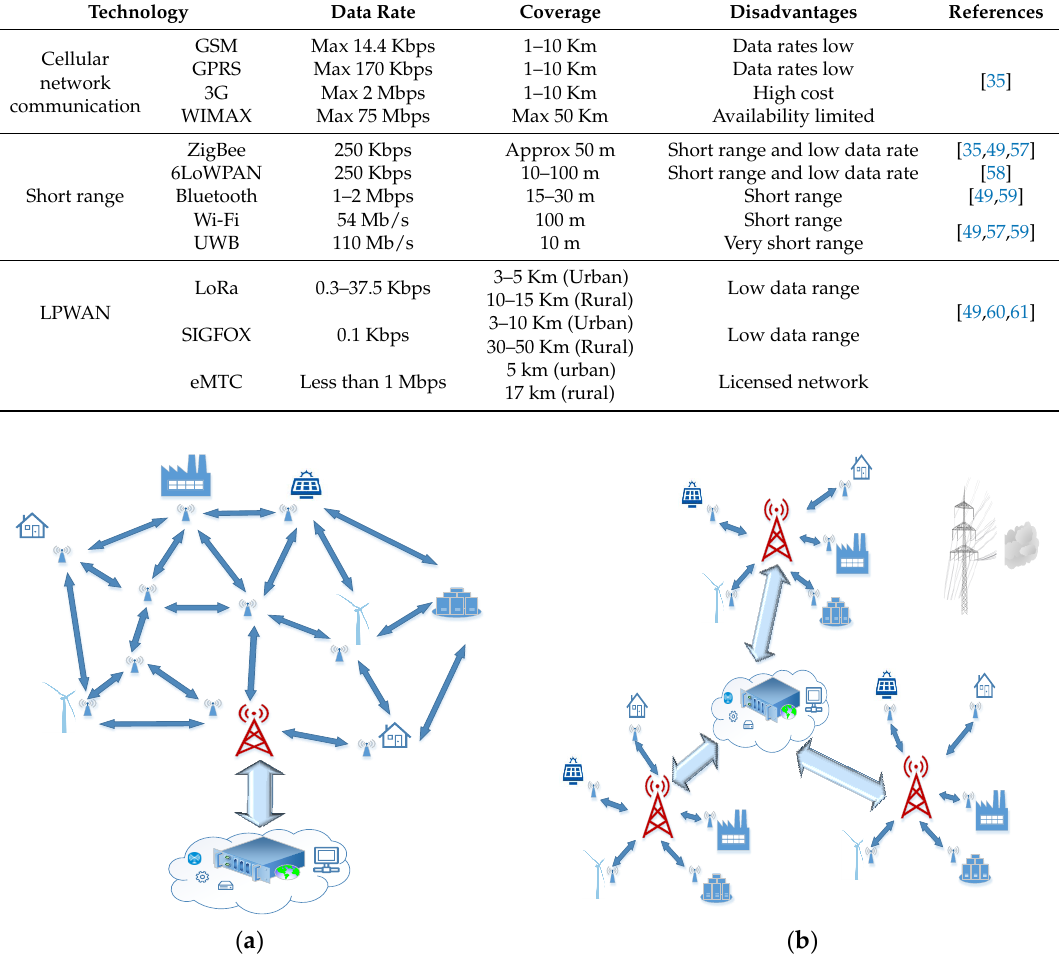
Figure 2. A schematic illustration of ( a ) the mesh topology of ZigBee and ( b ) the start topology of LoRa communication protocols.